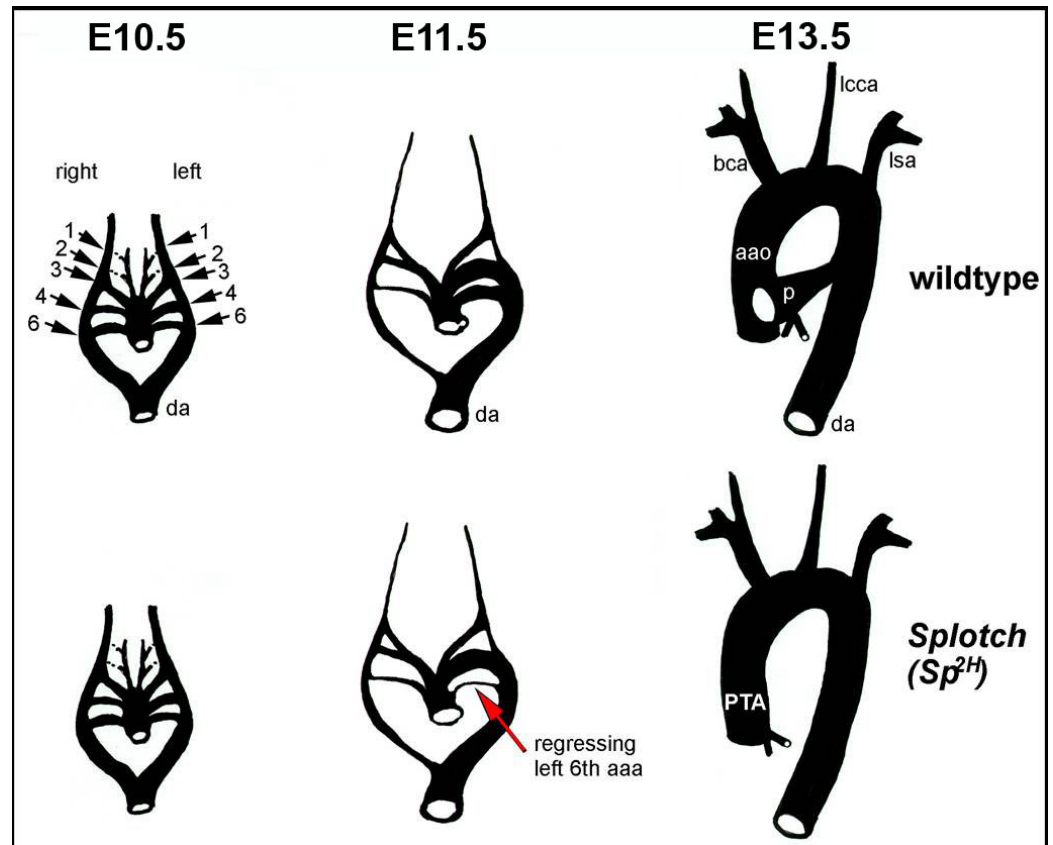
FIGURE 2. Schematic representation of the sequential changes that occur during remodeling of aortic (pharyngeal) arch arteries. Following ink injection analysis[58] of both age-matched wild-type and sp 2H mutant littermate embryos, representative vascular casts were schematized. Upper panel indicates the normal pattern of regression and lower panel indicate the anomalous remodeling occurring within the sp 2H mutant mouse. Normal remodeling. Note that there are initially six symmetrical arteries attached to the paired dorsal aorta (da) that are remodeled to give rise to a separate ascending aorta (aao; partly derived from the left fourth artery) and pulmonary trunk (p; derived from the left sixth artery) with two pulmonary arteries attached. Elements of the brachiocephalic artery (bca) are derived from the right fourth/sixth arteries, the left common carotid artery (lcca) is derived from the left third artery, and the left subclavian (lsa) is derived from the seventh intersegmental artery. Sp 2H remodeling. Note there are initially six symmetrical arteries, but that the left sixth (which normally gives rise to the pulmonary trunk) abnormally regresses, resulting in only a single OFT vessel and